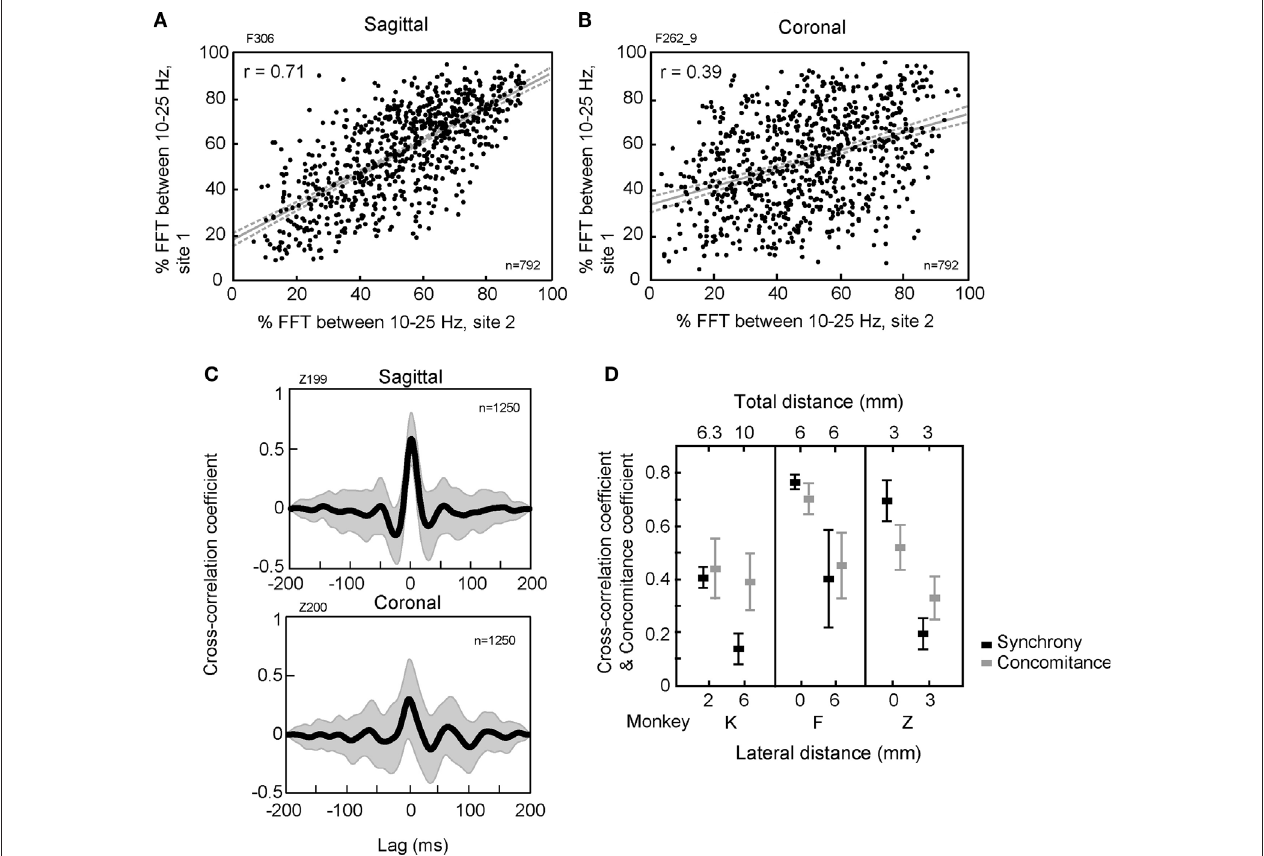
FIGURE 2 | Oscillation and synchronization properties of cerebellar GCL LFPs during rest. (A,B) Relationship between the 10–25 Hz oscillatory content (% of the LFP signal between 10–25 Hz) at both recording sites for a sagittal and a coronal pair in monkey F. Linear correlation value ( r ), regression line and 95% confi dence interval indicated. (C) Averaged